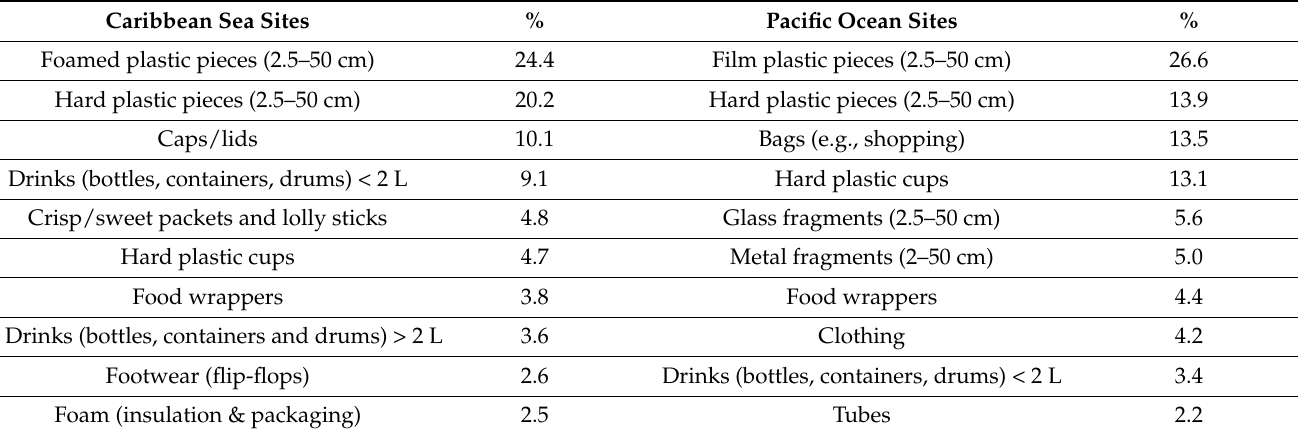
Table 4. Most numerous litter items in the Caribbean Sea and Pacific Ocean coasts of